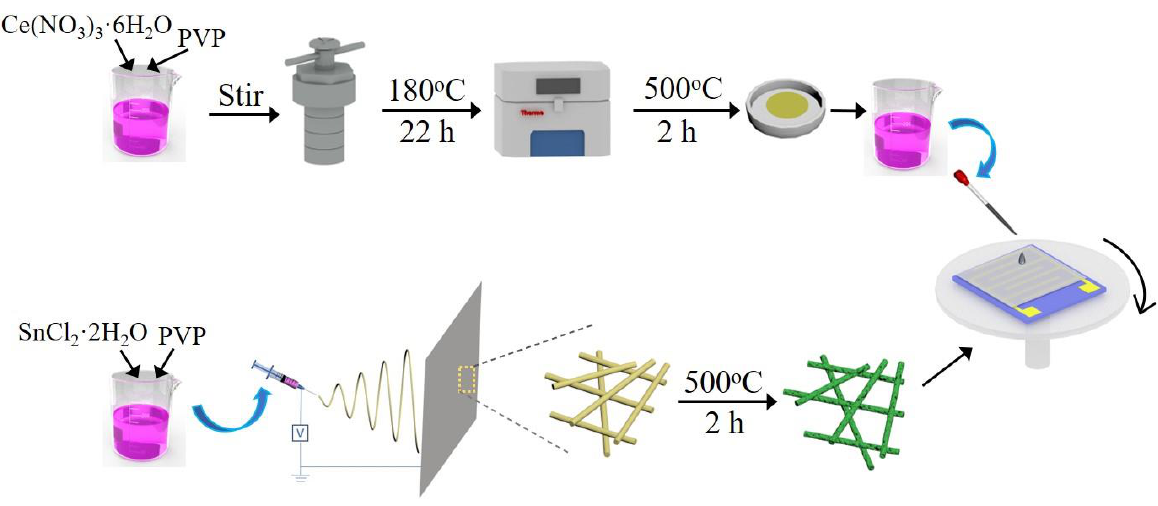
Figure 1. Schematic preparation process of the SnO 2 /CeO 2 composite.